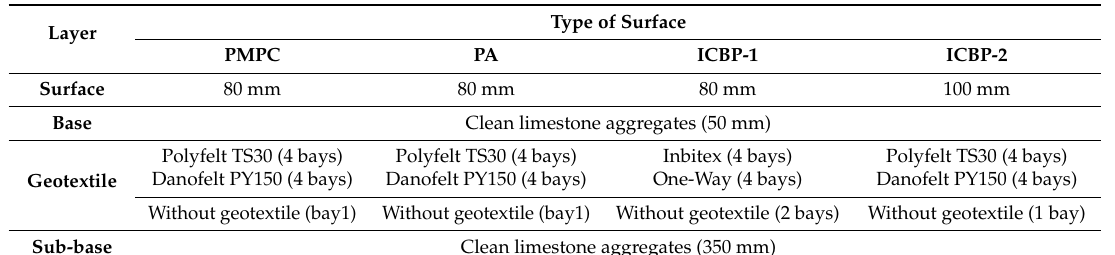
Table 1. PPS structure in the 37 car park